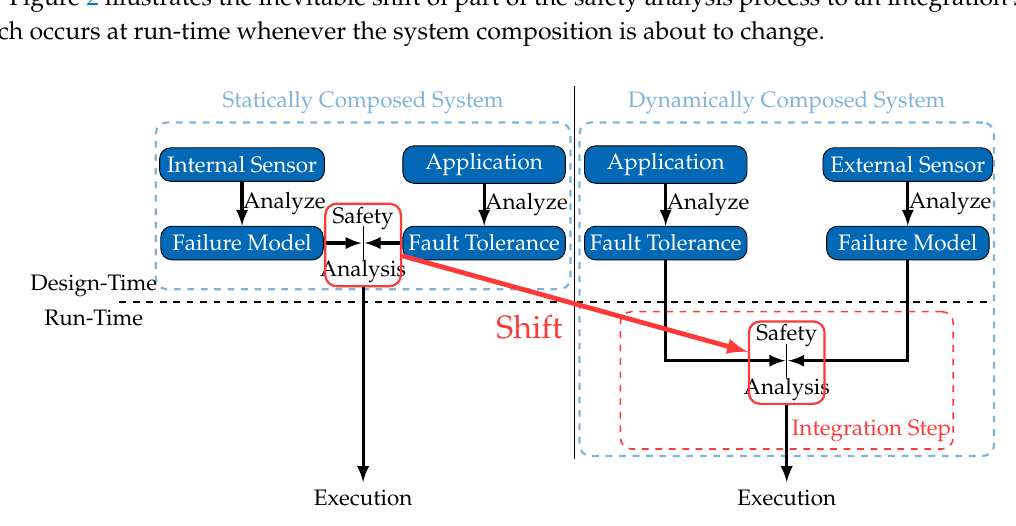
Figure 2. Comparison of safety analysis in statically composed systems and dynamically composed systems